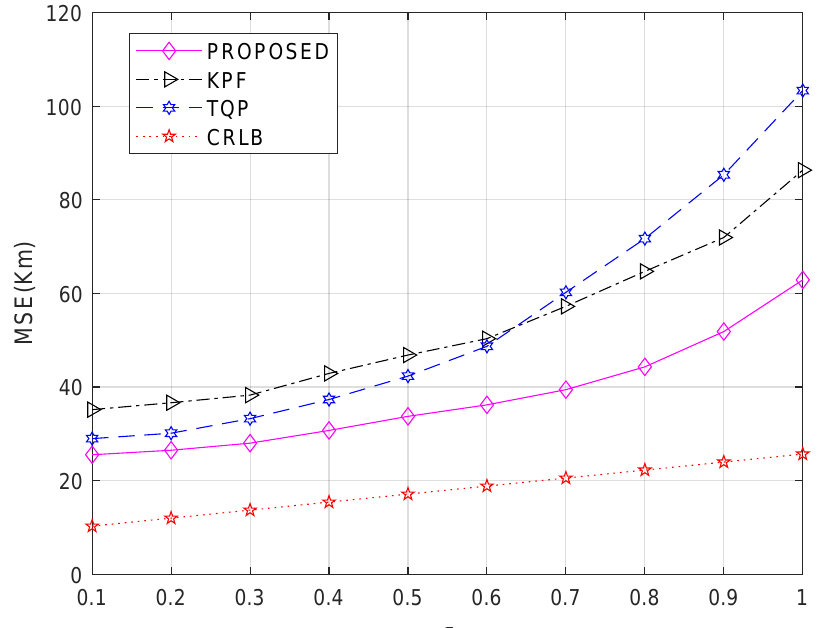
Figure 3. MSE of HF source position estimation with different values of σ